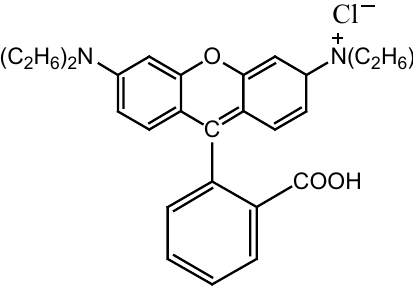
Fig. 2 Structure of Rhodamine B (Rh-B) dye (Inyinbor et al.